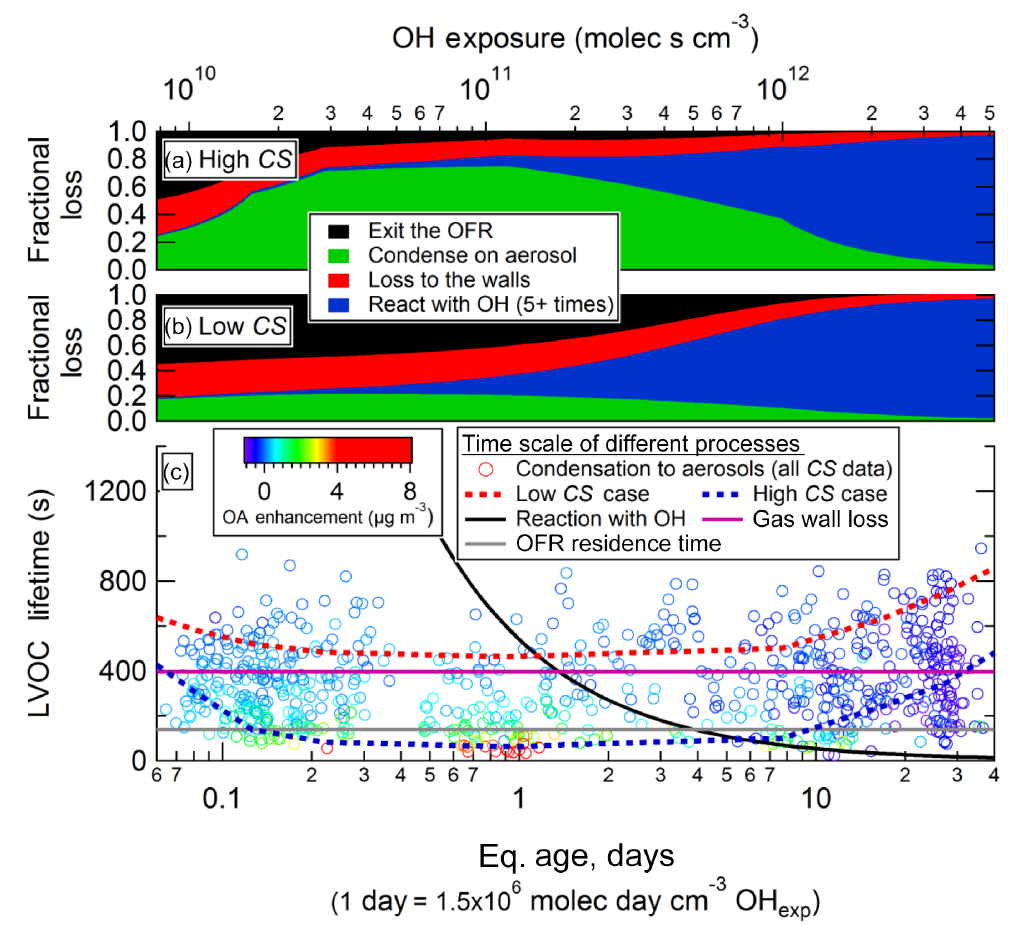
Figure 5. Fractional fates of loss of LVOCs to OFR walls, condensation to aerosols, reaction with OH to produce volatile products, or exiting the OFR to be lost on sampling line walls as a function of photochemical age for (a) high-CS and (b) low-CS cases; (c) LVOC lifetimes for each of these pathways. Lifetime for condensation to aerosols is shown for all data points (colored by OA enhancement after oxidation) using CS calculated from SMPS